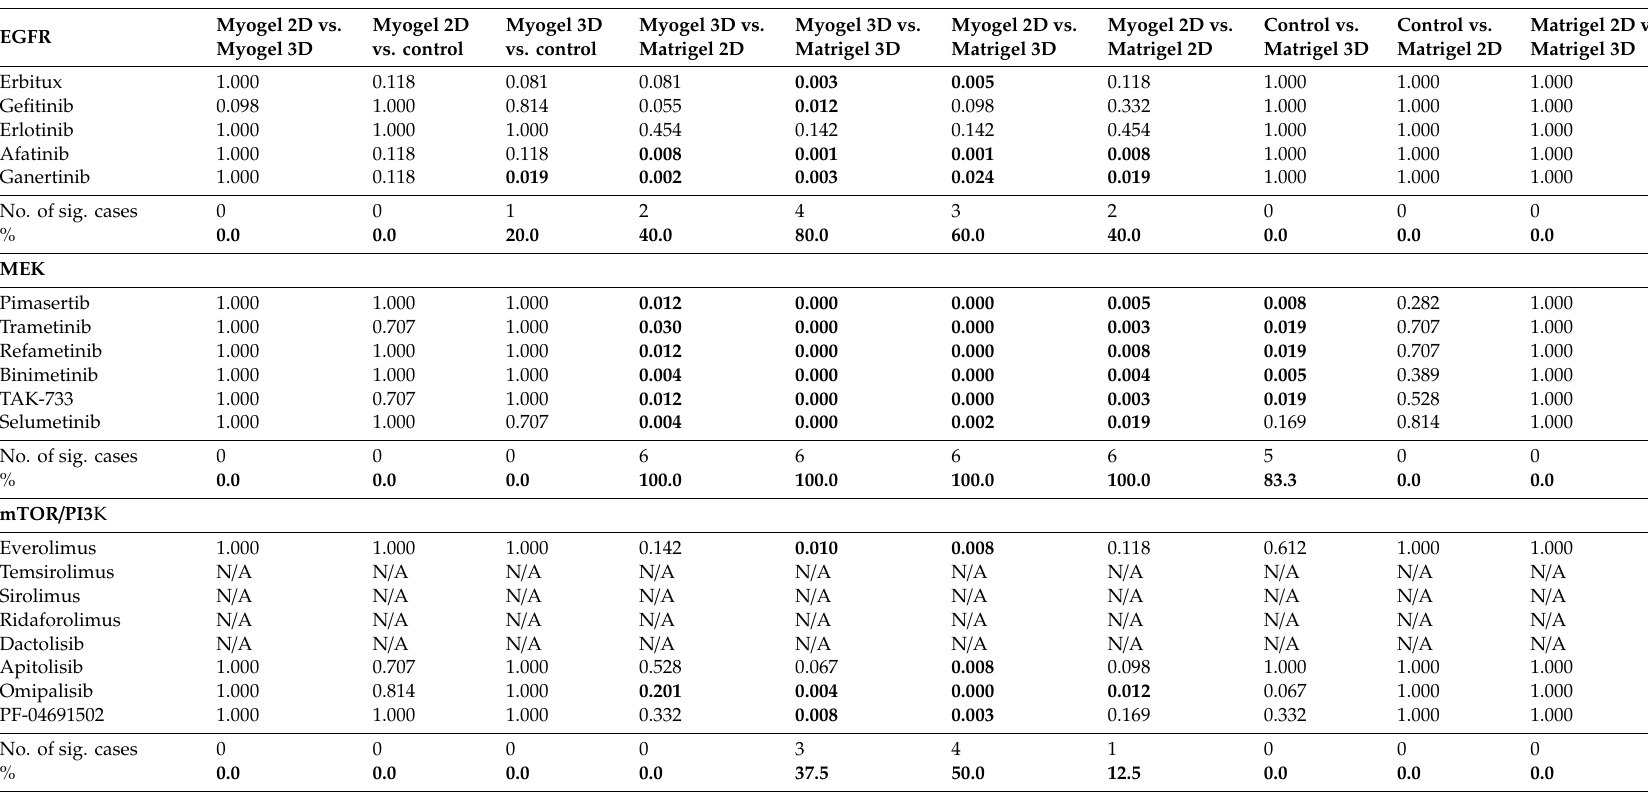
Table 1. Comparison of the culturing conditions for each anticancer compound. Adjusted p -values were collected, and the number and percentage of significant cases in the drug groups (EGFR, MEK, and mTOR / PI3K) were calculated. Significant di ff erences appear in bold. (N / A, not